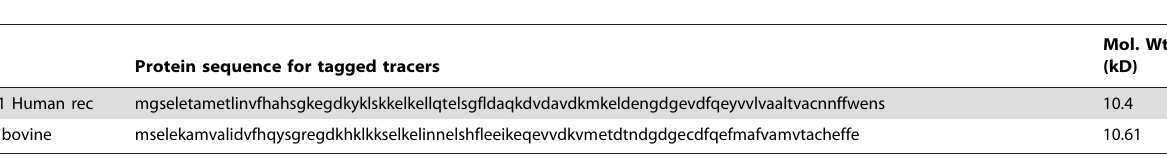
Table 2. Comparison of S100B and S100A1 sequences to underscore similarities (normal character) and differences (in bold).